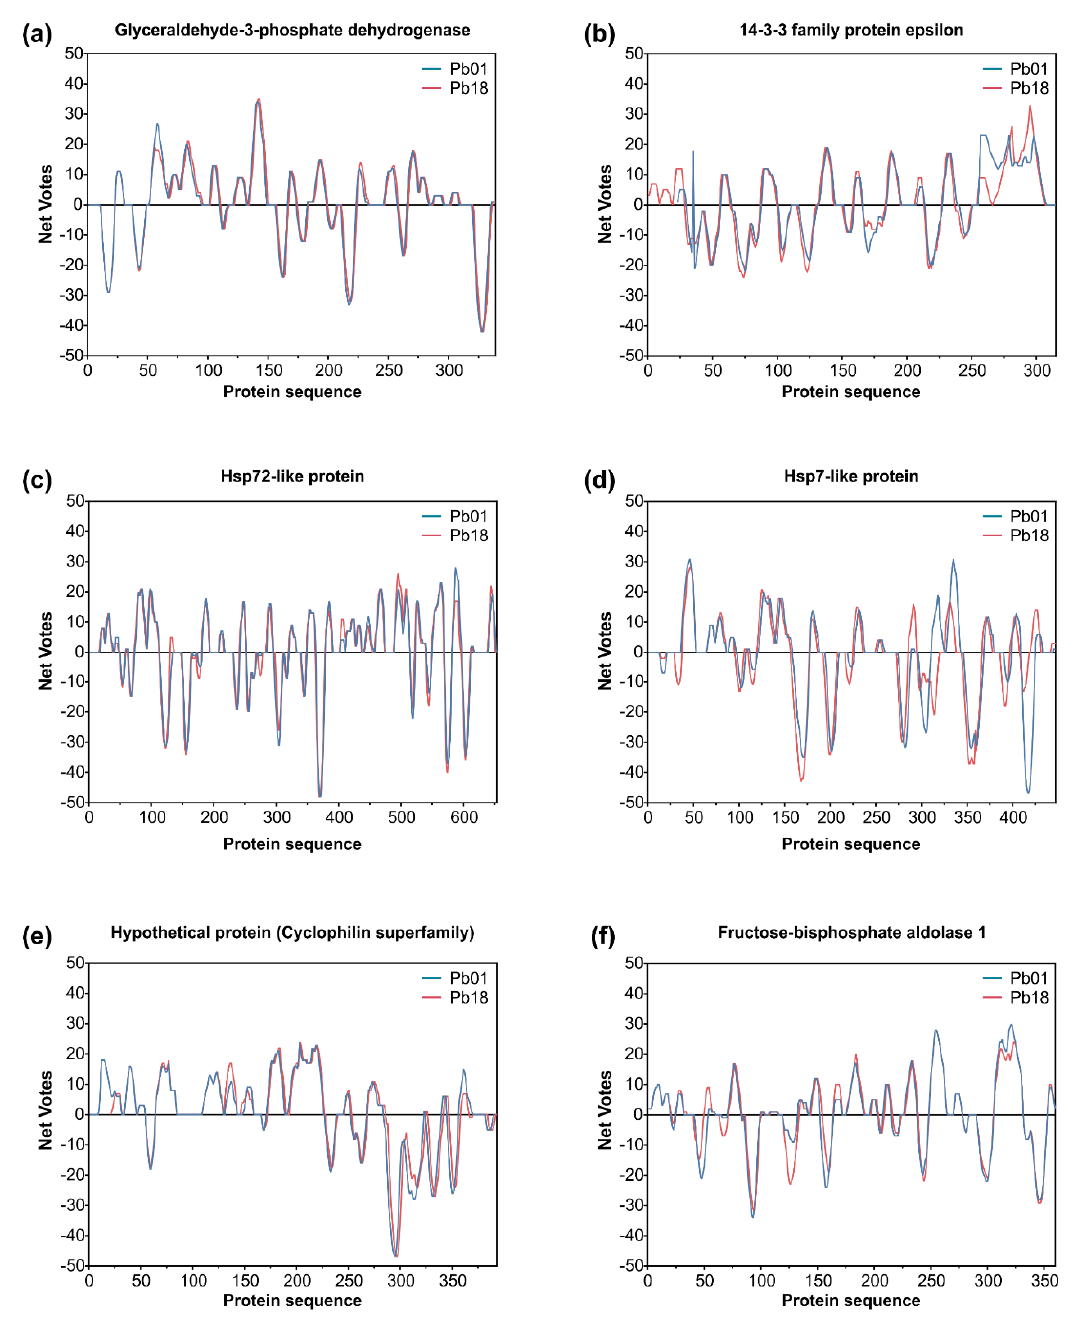
Figure 7. Immunoreactive proteins found in the P. brasiliensis immunoproteome with the highest antigenic scores. Residue epitope propensity score predictions for ( a ) glyceraldehyde-3-phosphate dehydrogenase (Q8 × 1 × 3 and XP_010758444), ( b ) 14-3-3 family protein epsilon (XP_002796914 and XP_010759301), ( c ) HSP72-like protein (XP_002790117 and XP_010763478), ( d ) HSP7-like protein (XP_015703361 and XP_010756347), ( e ) uncharacterized protein—cyclophilin superfamily protein (XP_015701903 and XP_010761900), and ( f ) fructose-bisphosphate aldolase 1 (XP_002796107 and XP_010756450). The antigenic propensity scores are plotted against position along the amino acid sequence as predicted by the COBEpro algorithm [82] . The higher the antigenic propensity scores, the more likely is the antigenic activity for the respective region. COBEpro uses a support vector machine to assign epitope propensity scores to peptide fragments.